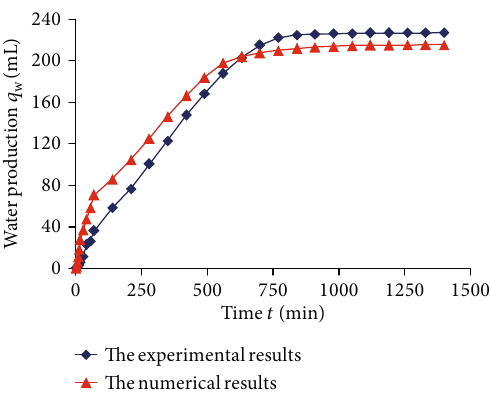
Figure 6: The variation of cumulative water production with time in 3-D marine sediments for the whole water production process.